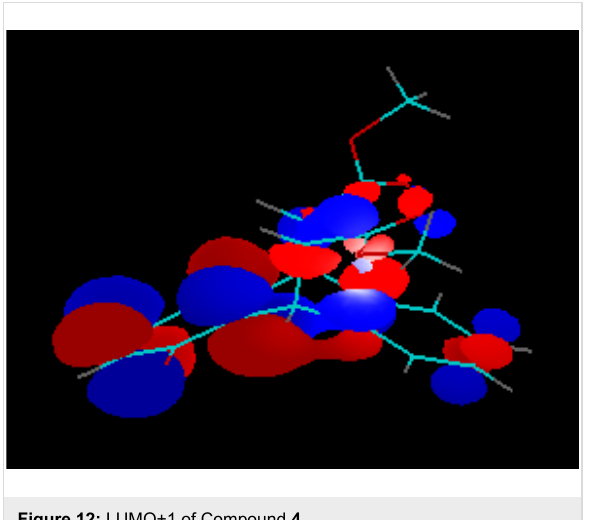
Figure 12: LUMO+1 of Compound 4 .